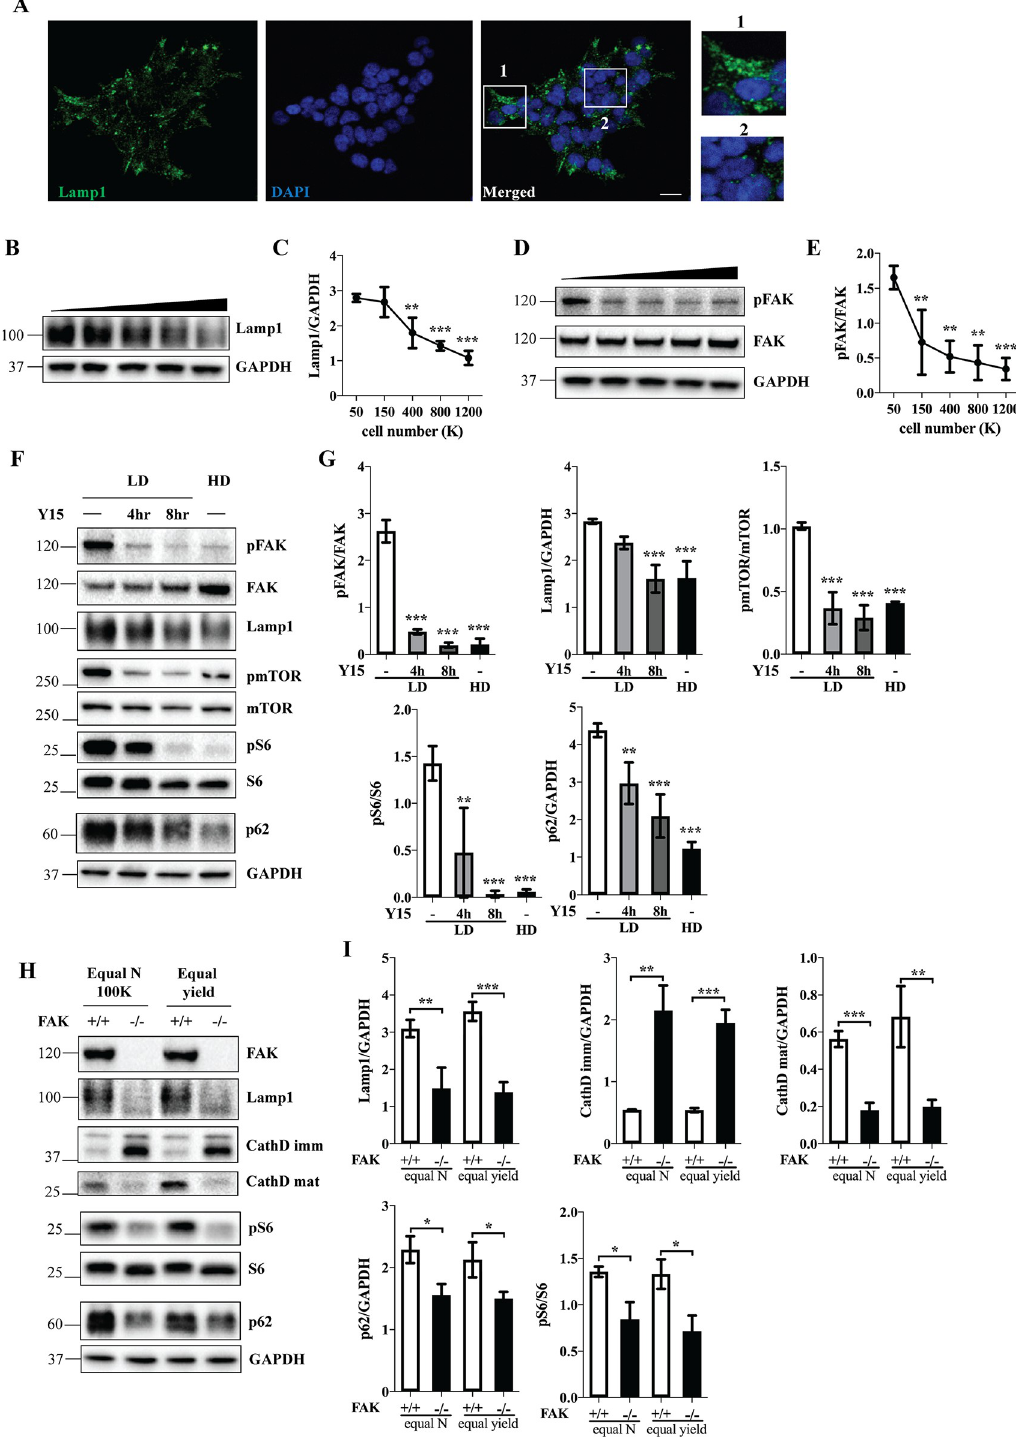
Fig 3. Cell crowding regulates lysosomes, autophagy and mTOR signaling in a FAK-dependent manner. (A) HEK 293FT cells were plated at 100K on coverslips placed in a 6 well plate, incubated for 2 days, fixed and stained against Lamp1; DAPI was used to visualize nuclei. 1, edge cell; 2, non-edge cell. Scale bar, 20 μ m. (B,D) HEK 293FT cells were plated at a range of densities and incubated for two days. Cell lysates were analyzed by Western blotting using indicated antibodies. GAPDH was used as a loading control. (F) Cells were plated at low (LD) or high (HD) density and treated with the vehicle (-) or 25 μ M FAK inhibitor